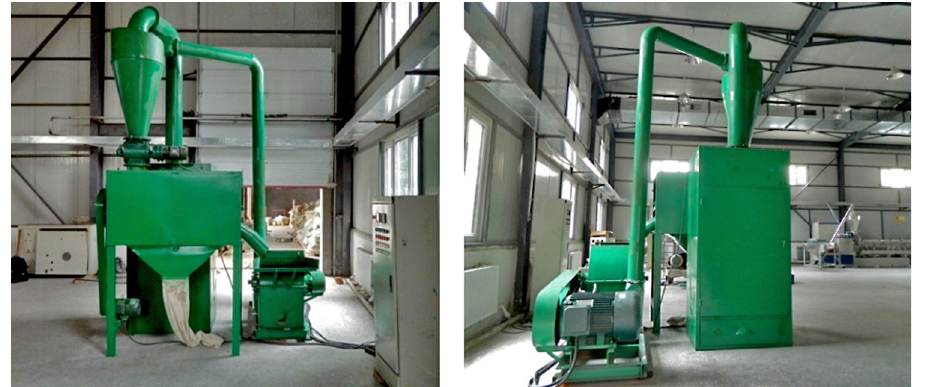
Fig 3. Biomass fiber crusher.